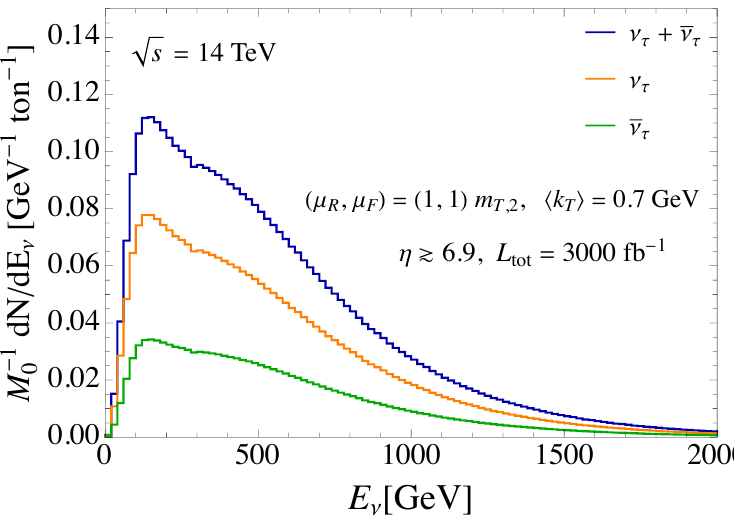
Figure 20. The same as figure 17, except for the pseudorapidity range and the integrated lumi- nosity, which in this plot are set to η > 6 . 9 and L = 3000 fb − 1 ,